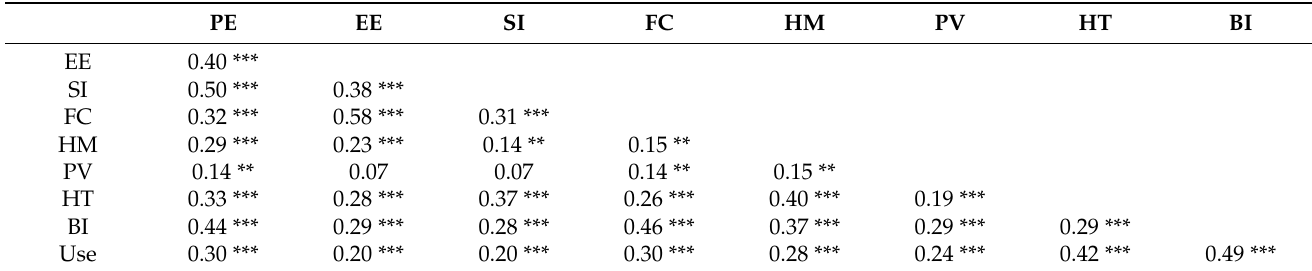
Table 2. Construct correlations indicating instrument